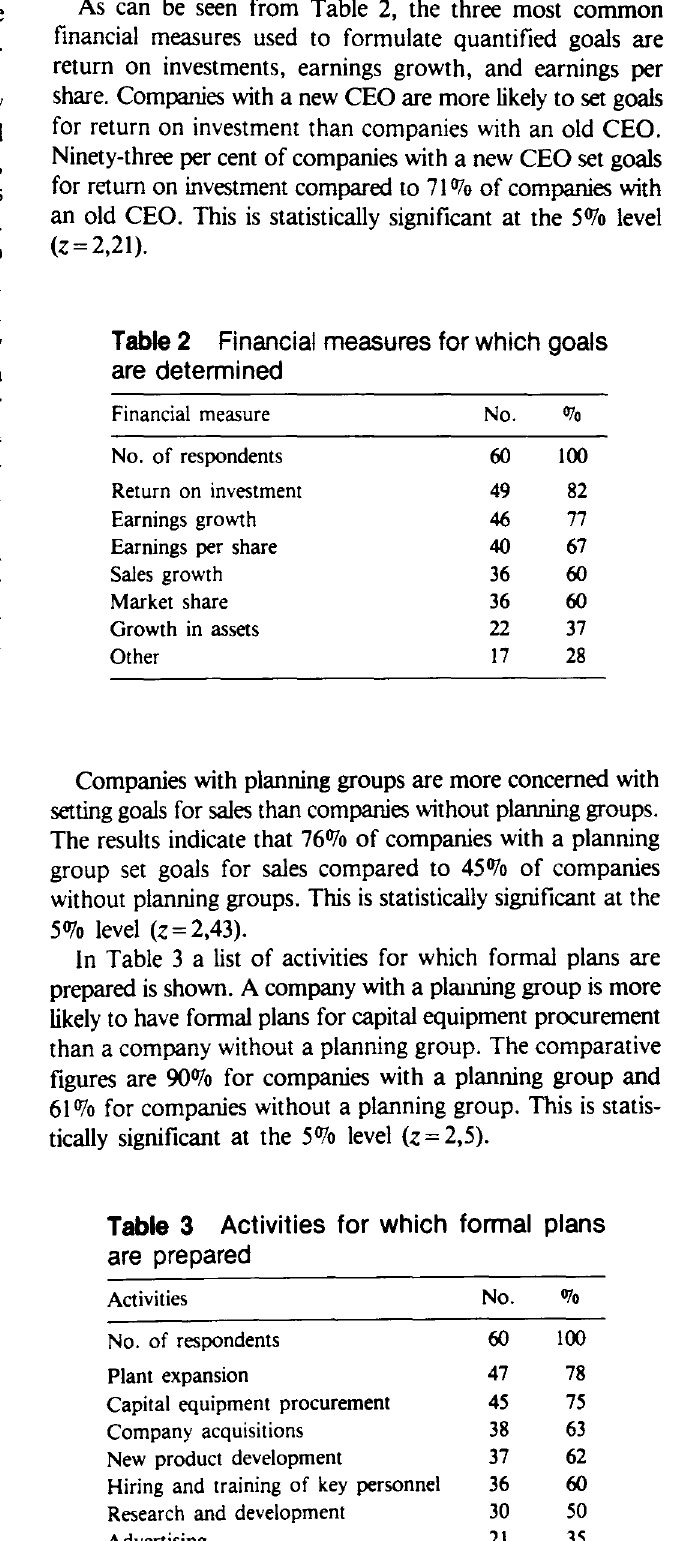
External factors considered during the strategic planning